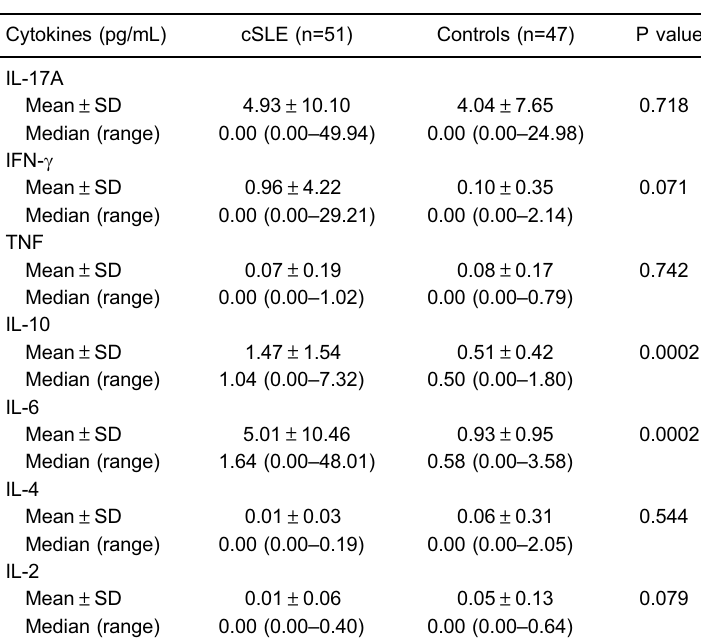
Table 2. Comparison of concentrations of cytokines in childhood-onset systemic lupus erythematosus (cSLE) patients and healthy